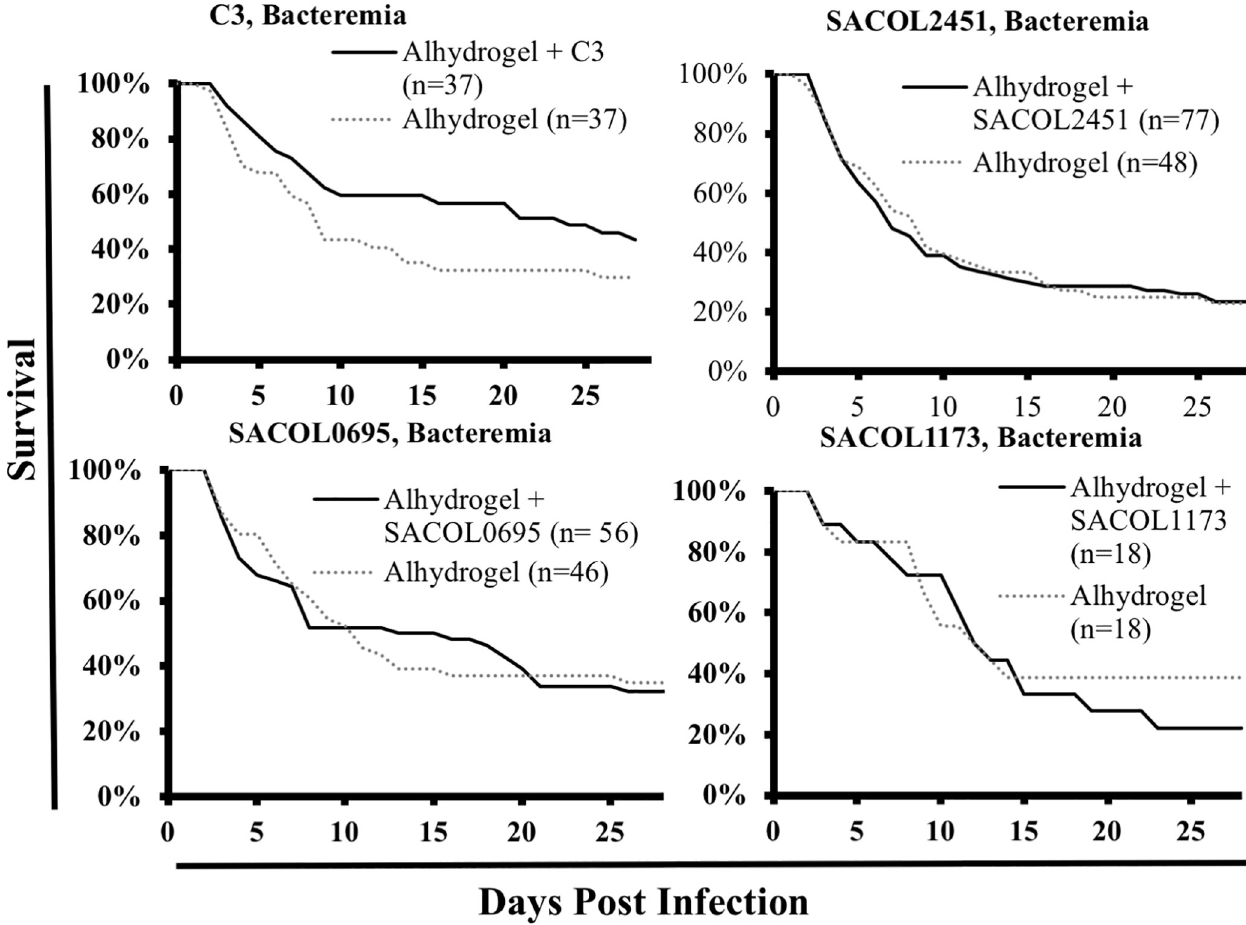
Fig 6. Group "C3" efficacy, bacteremia model. BALB/c mice were immunized and then challenged with a S . aureus IV infection. Mice were monitored daily and euthanized when moribund. We had previously observed mixed results when immunizing mice with the different regimens and therefore we carried out 4 independent experiments (combined n = 37 mice). Immunization and infections were standardized across experiments. No significant difference was observed between immunized and control mice. "C3" is composed of an equal mixture of SACOL1173, SACOL2451, and SACOL0695